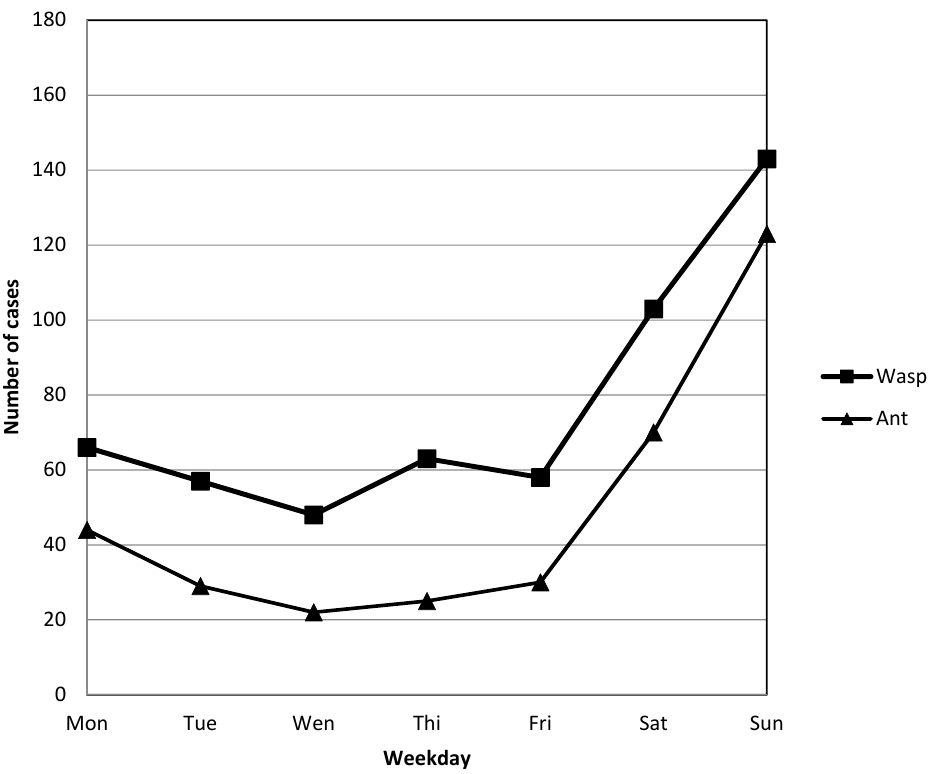
Figure 3. Distribution of cases per weekday (case numbers are depicted according to the day of the week).